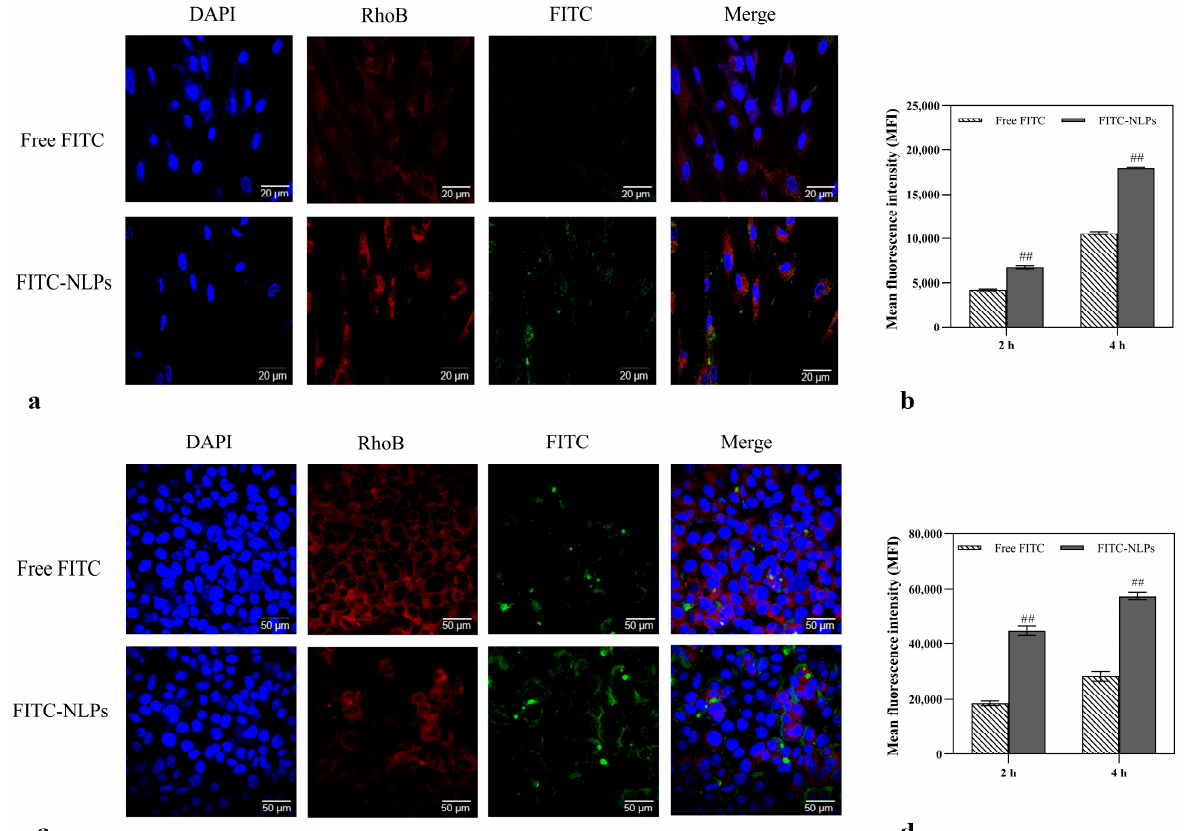
Figure 4. CLSM images of ( a ) HSF cells (Scale bar: 20 µ m) and ( c ) B16F10 cells (Scale bar: 50 µ m) showing the subcellular distribution of FITC. The cells were treated with 2 µ g/mL free FITC and equal FITC concentration of FITC-NLPs for 4h. DAPI (blue) and RhoB (red) were utilized to label the nucleus and cytoplasm, respectively. Cellular uptakes of FITC by ( b ) HSF cells and ( d ) B16F10 cells were further analyzed by FCM and presented as relative mean fluorescence intensity (MFI). The FCM samples were analyzed after treating cells with free FITC or FITC-NLPs at a fixed FTIC dosage of 2 µ g/mL for 2 h or 4 h. Mean ± SD ( n = 3). ## p < 0.01, compared with the free FITC